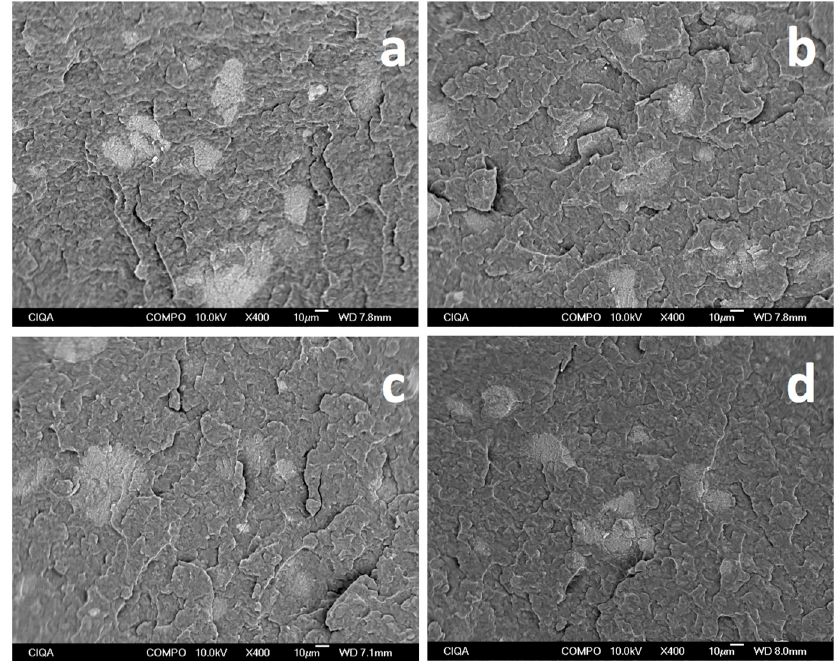
Figure 5. Low-magnification SEM micrographs for iPP MFI=34 /MWCNT fabricated using different ultrasound-assisted extrusion methods ( a ) W-U; ( b ) F-U’ ( c ) V-U; and ( d ) PT.